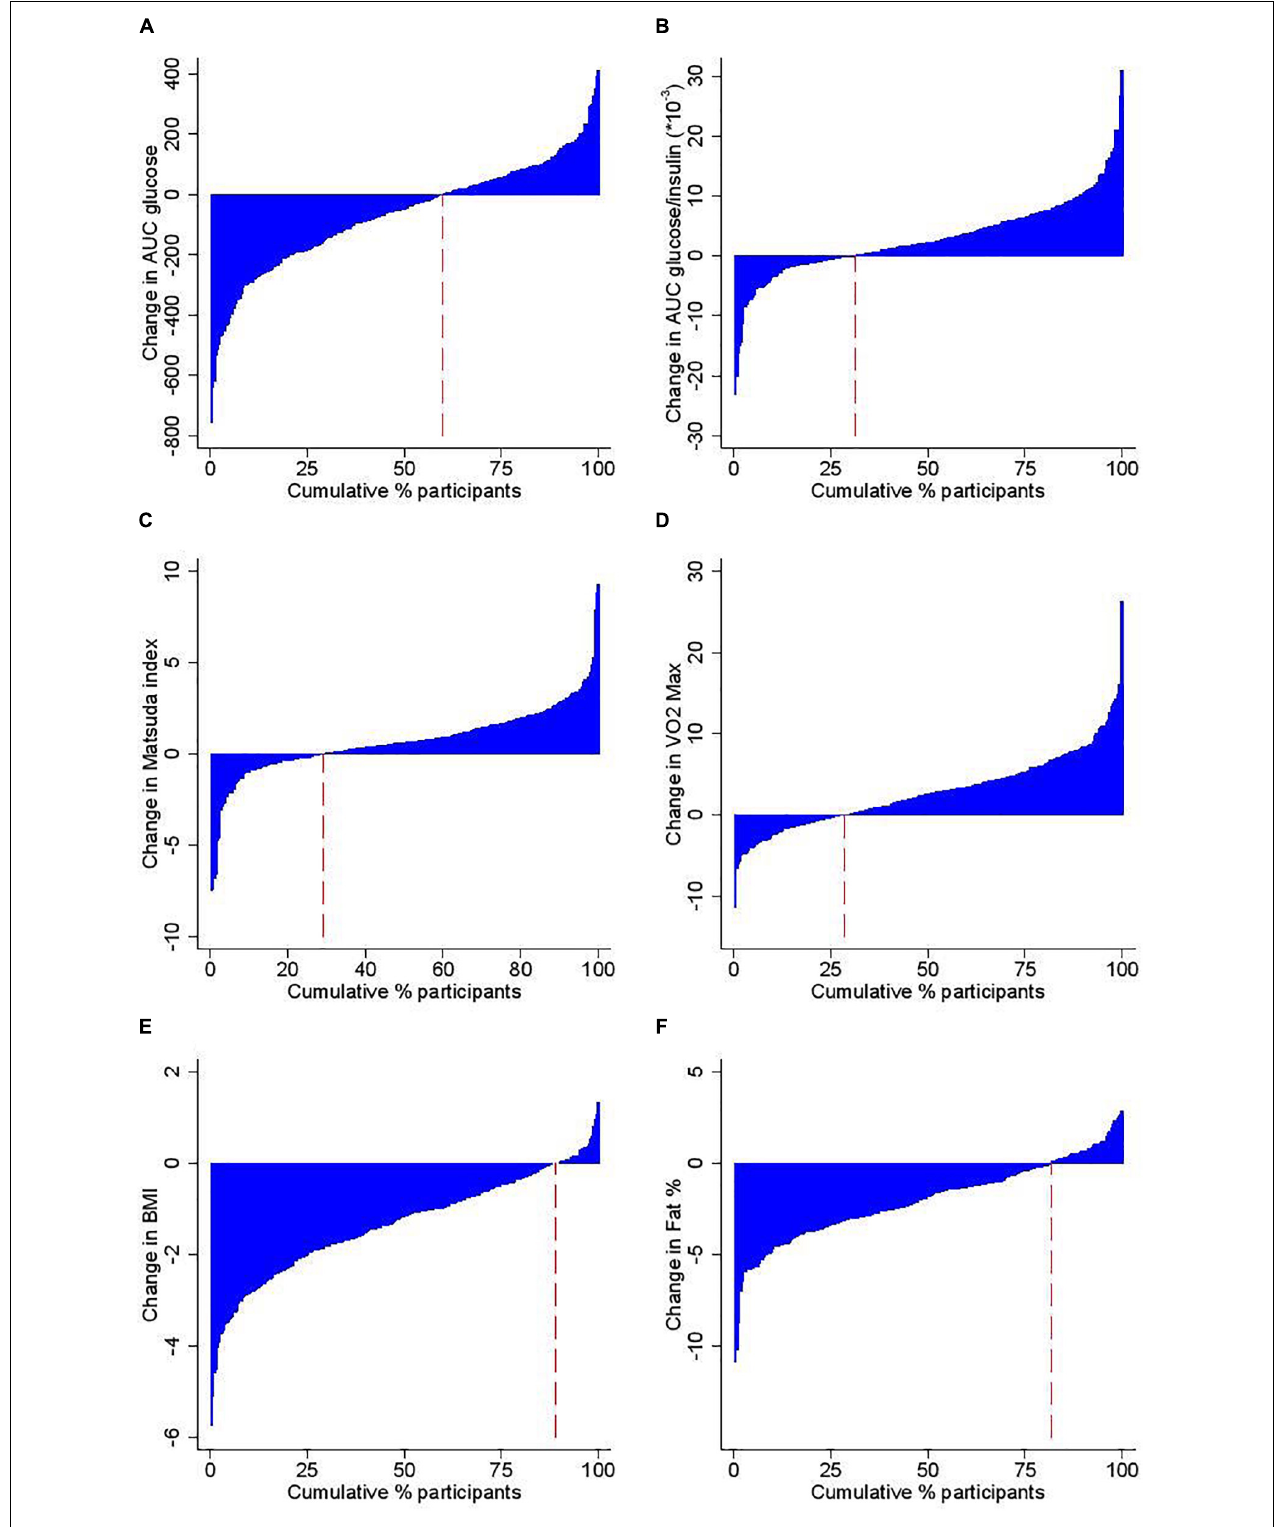
FIGURE 1 | Study participants according to change following the 12 week intervention in (A) Area Under the Curve (AUC) for Glucose during the OGTT, (B) AUC for Glucose/Insulin during the OGTT, (C) insulin sensitivity as estimated by the Matsuda index, (D) VO 2 max, (E) BMI, and (F) % body fat. The red dashed line indicates the proportion of individuals with a lowered outcome level after the